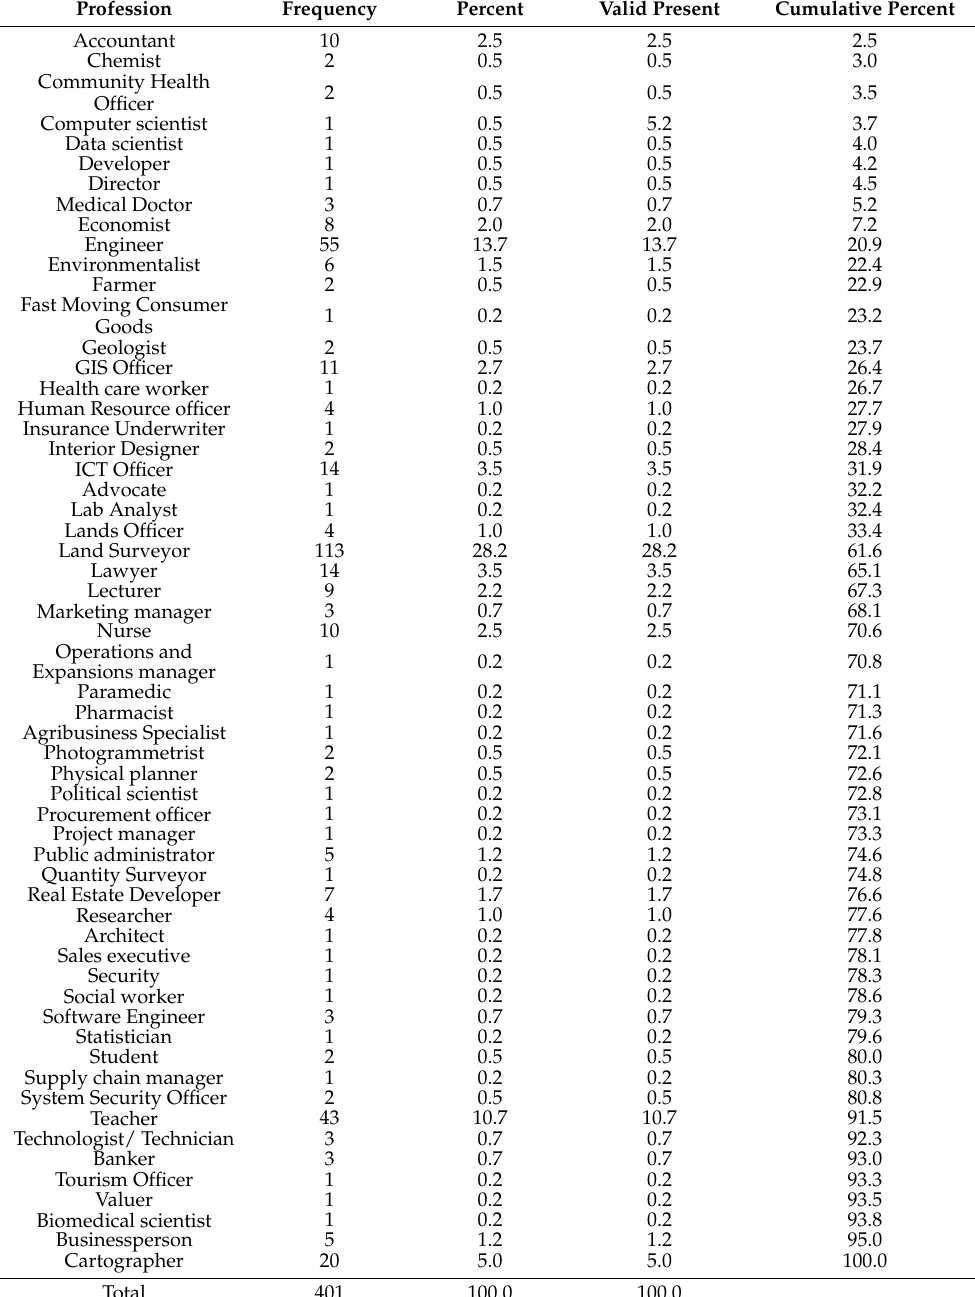
Table A3. The profession of respondents ( n =